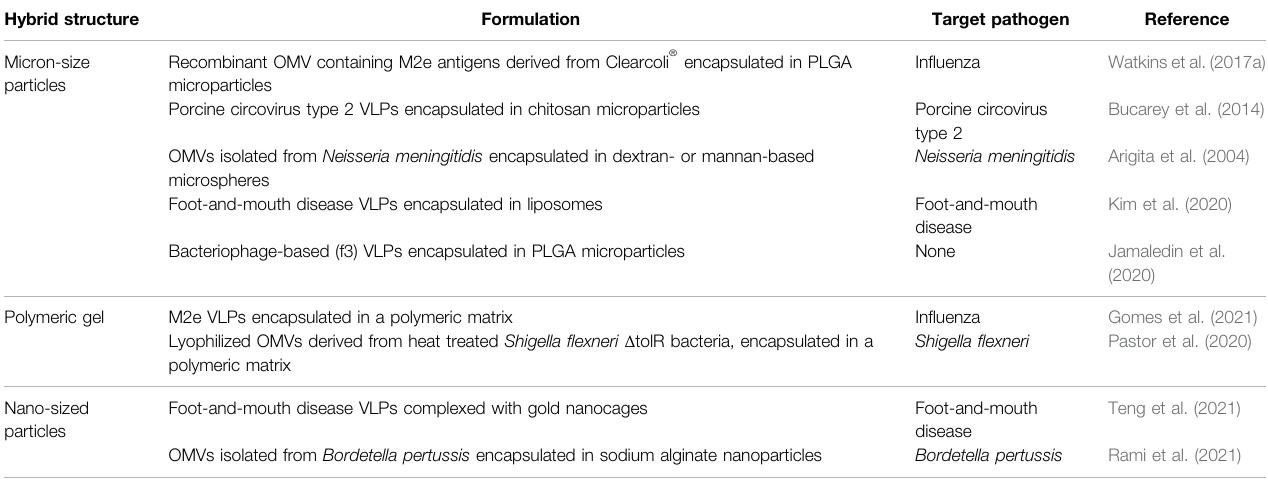
TABLE 4 | Hybrid structures used in the formulation of biologically-derived